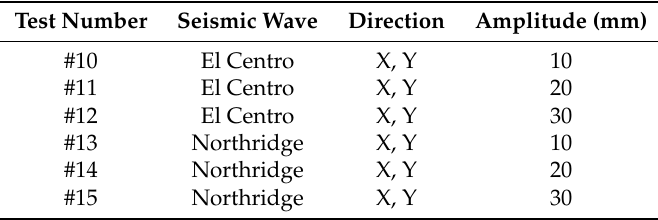
Table 3. Experiment scheme under seismic wave excitation.